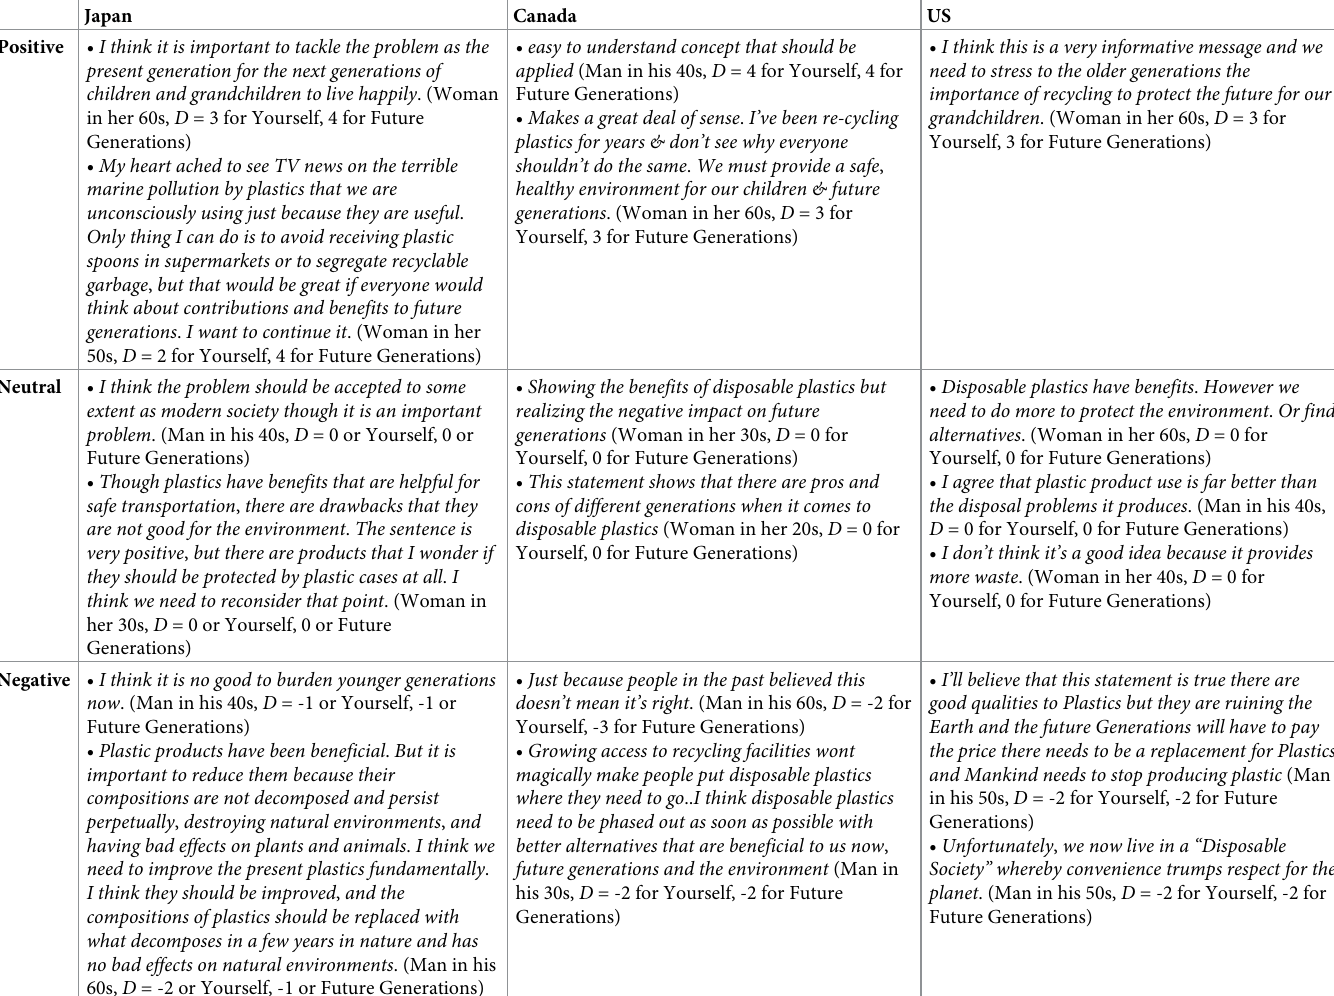
Table 9. Characteristic responses for